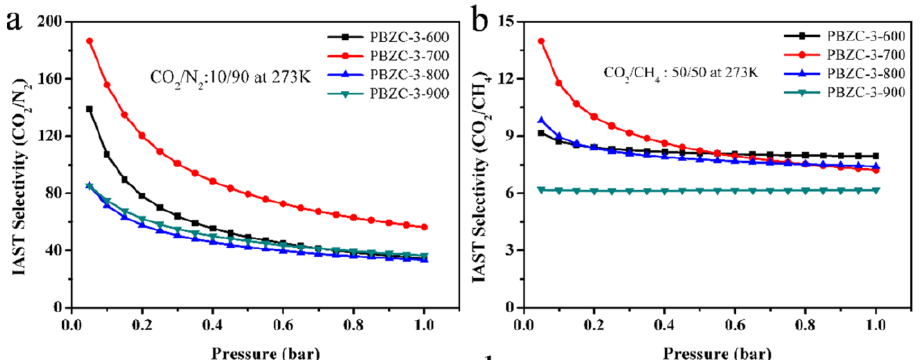
Figure 46. IAST selectivity factors of CO 2 adsorption from ( a ) N 2 and ( b ) CH 4 (reproduced from the work in [108] with